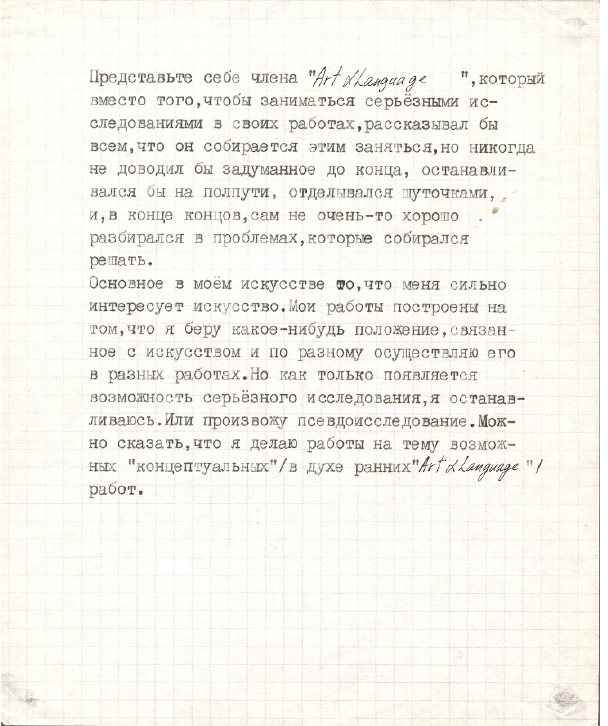
Figure 18. Albert. Autoseries I. 1979–1980. Paper. 20.2 cm × 16.5 cm. Courtesy of the artist.